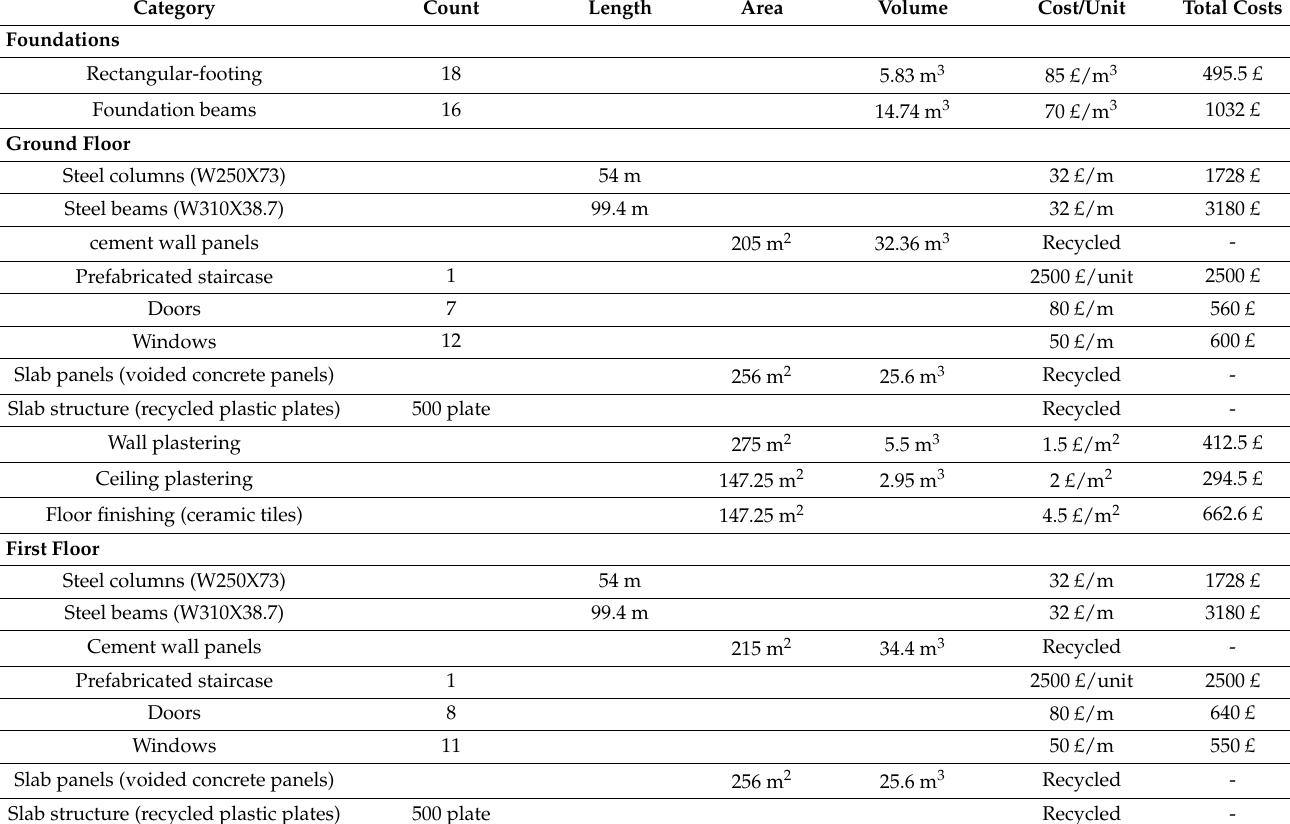
Table 4. Construction cost estimation using BIM